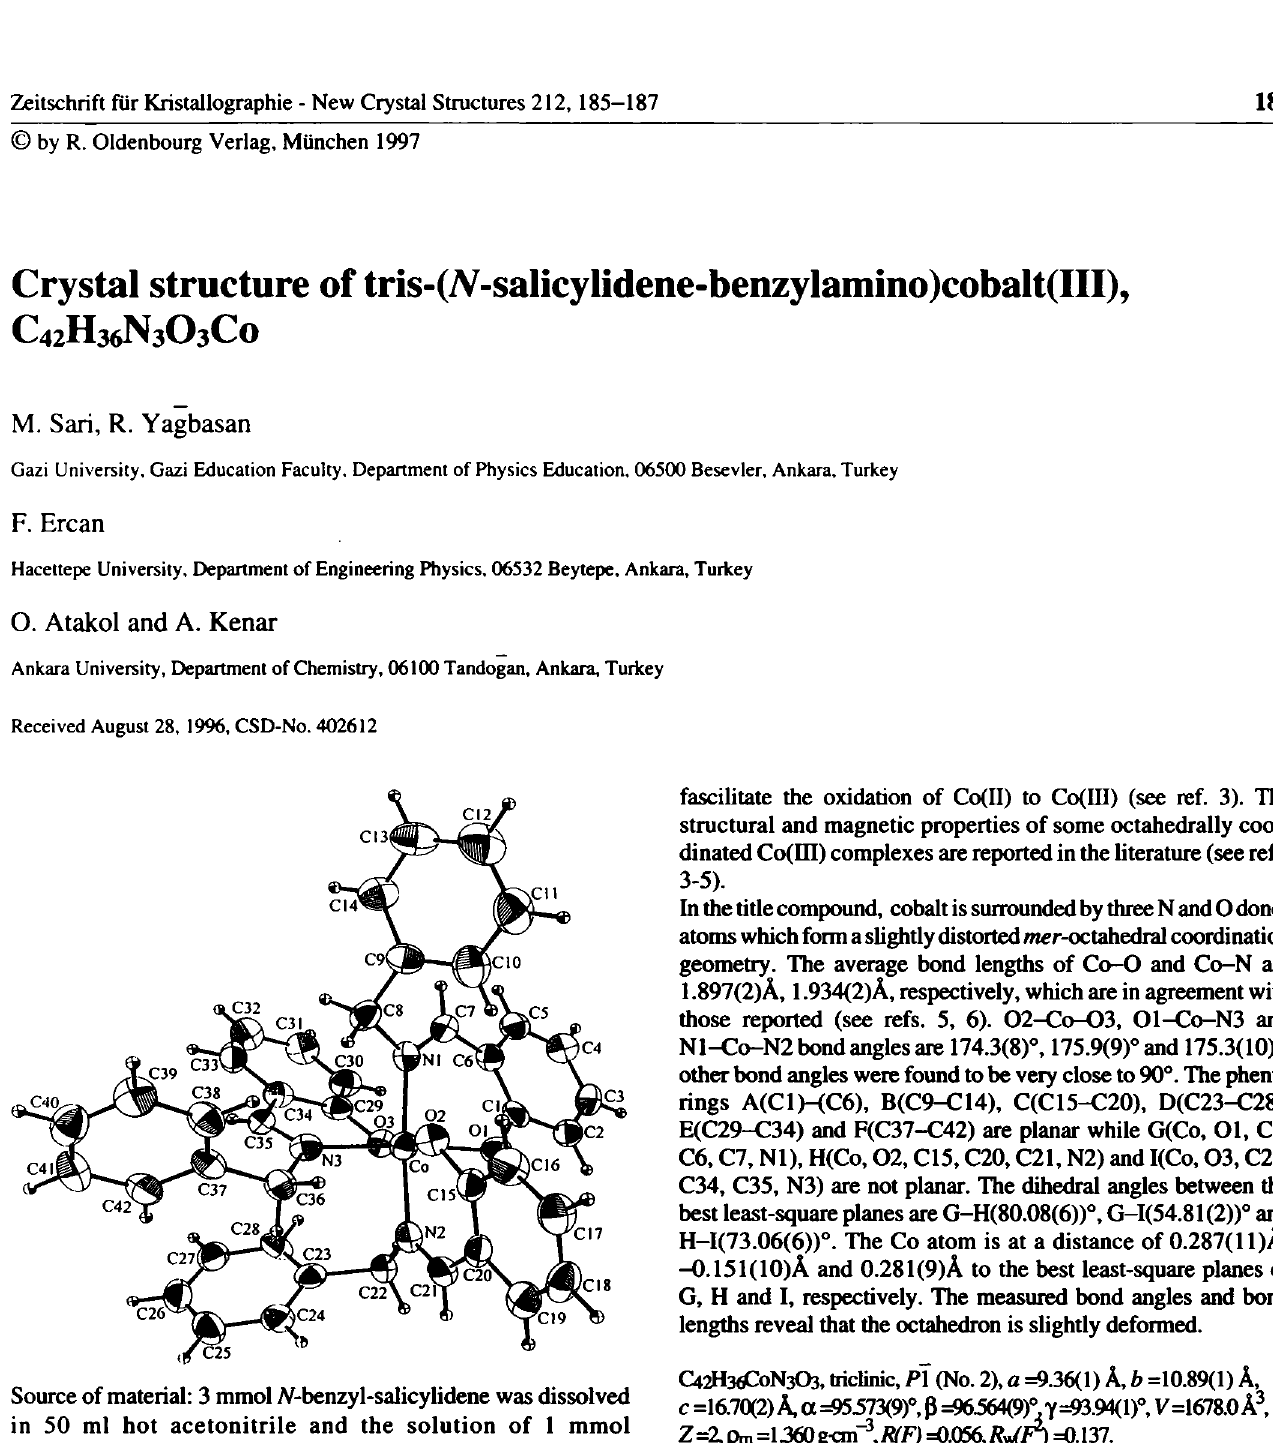
Table 1. Parameters used for the X-ray data collection